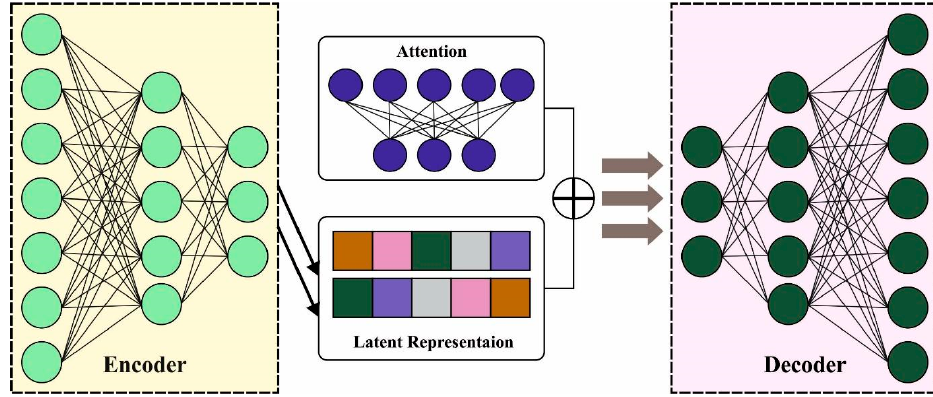
Figure 3. The Architecture of the ARAE model.